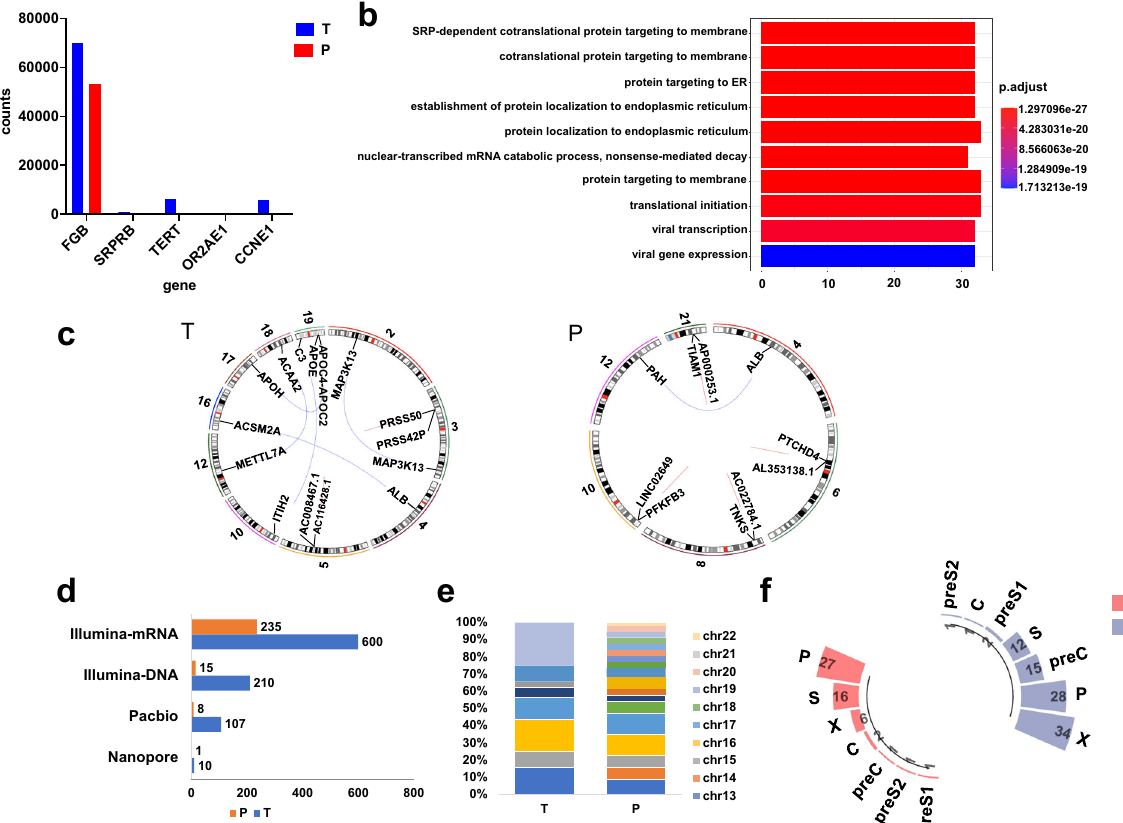
Fig. 5 HBV integration patterns and gene expression in HCC tumor and adjacent tissue. a Gene expression in HBV integration affected genes (human breakpoint at promoter-TSS, 3 ′ UTR, and TTS) in HCC tumor (blue) and adjacent tissue (red). b Differential expression gene enrichment pathways in tumor and adjacent tissue. Each bar depicts one enrichment pathway. c Fusion genes in tumor and adjacent tissue. Each line represents a breakpoint of fusion sites on different genes. d Chimeric reads numbers detected in tumor (blue) and adjacent tissue (red) in the three platforms. e HBV integration breakpoints distribution in human chromosomes in tumor and adjacent tissue, different colors represent different chromosomes. f HBV integration breakpoints distribution in the HBV genome in tumor (red) and adjacent tissue